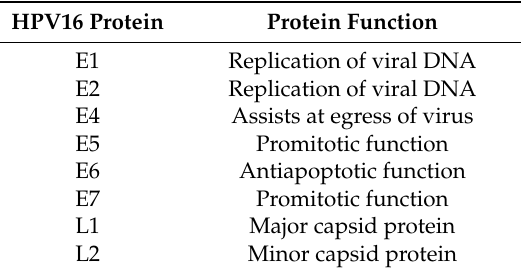
Table 1. Function of HPV16